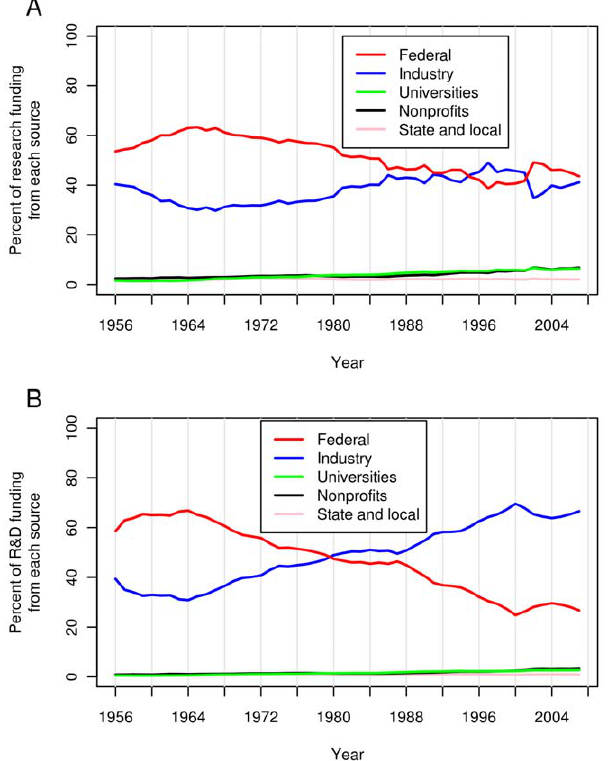
Figure 5. Five sources of research and research and develop- ment (R&D) funding in the US during the last six decades. Percentage of research (A) and R&D (B) spending derived from five different sources: 1. federal agencies, 2. industry, 3. universities and colleges, 4. nonprofit organizations, and 5. state and local governments.